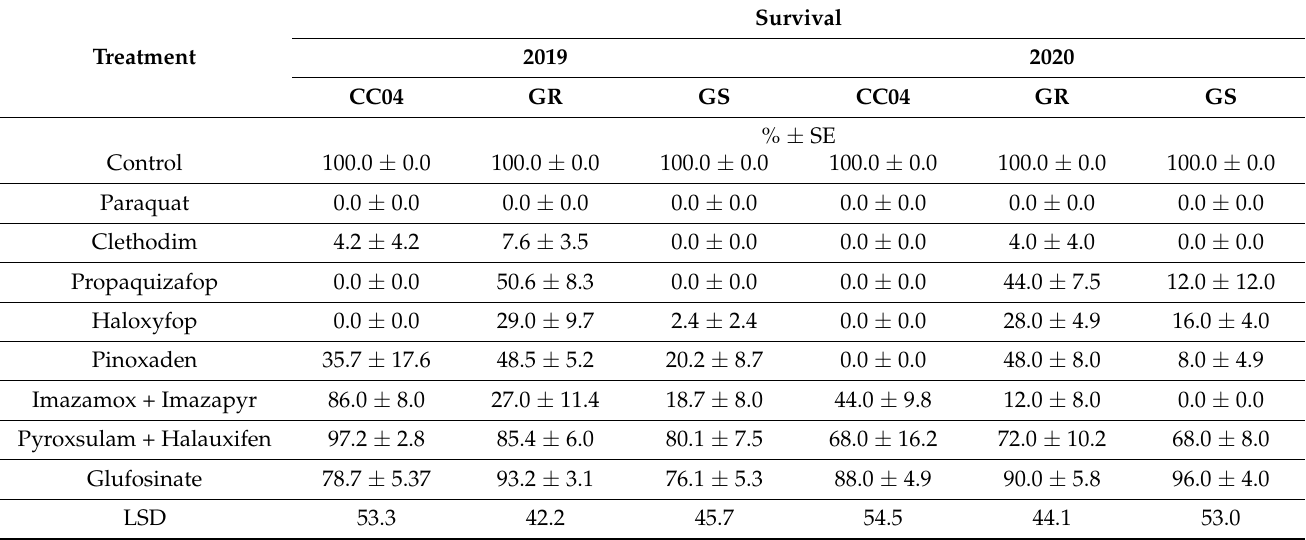
Table 4. Seedling survival of three Lolium rigidum populations to different herbicide treatments in two experimental runs (2019 and 2020). Data are presented as the mean ± the standard error (SE) of the mean.